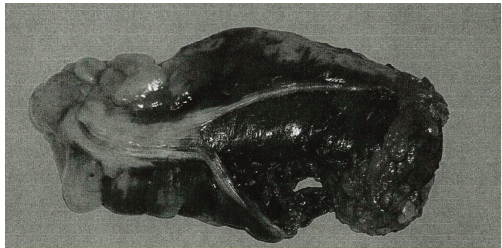
Figure 2: Surgical view shows an edematous rectal wall with hemorrhagic infiltration of the upper and medial rectal third. A seromuscular tear in the anterior tenia of the rectum is evident, together with an intact, bulging